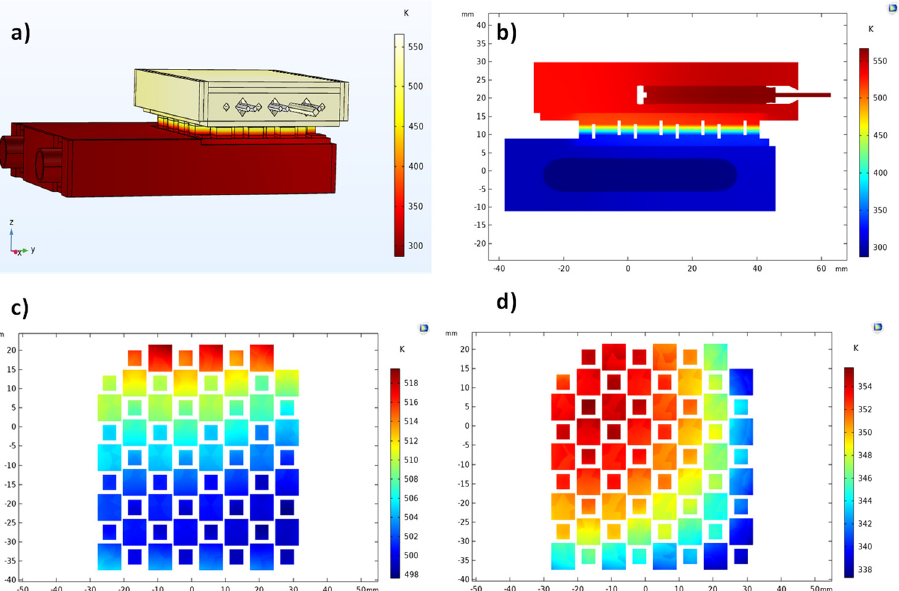
Figure 9. ( a ) Temperature distribution across the testing system when using silicide-tetrahedrite TEG with optimized geometry; ( b ) temperature distribution from a vertical plane cut taken from the middle of the plate; ( c ) temperature distribution on the top of the TEG legs (hot zone); ( d ) temperature distribution on the bottom of the TEG legs (cold zone).